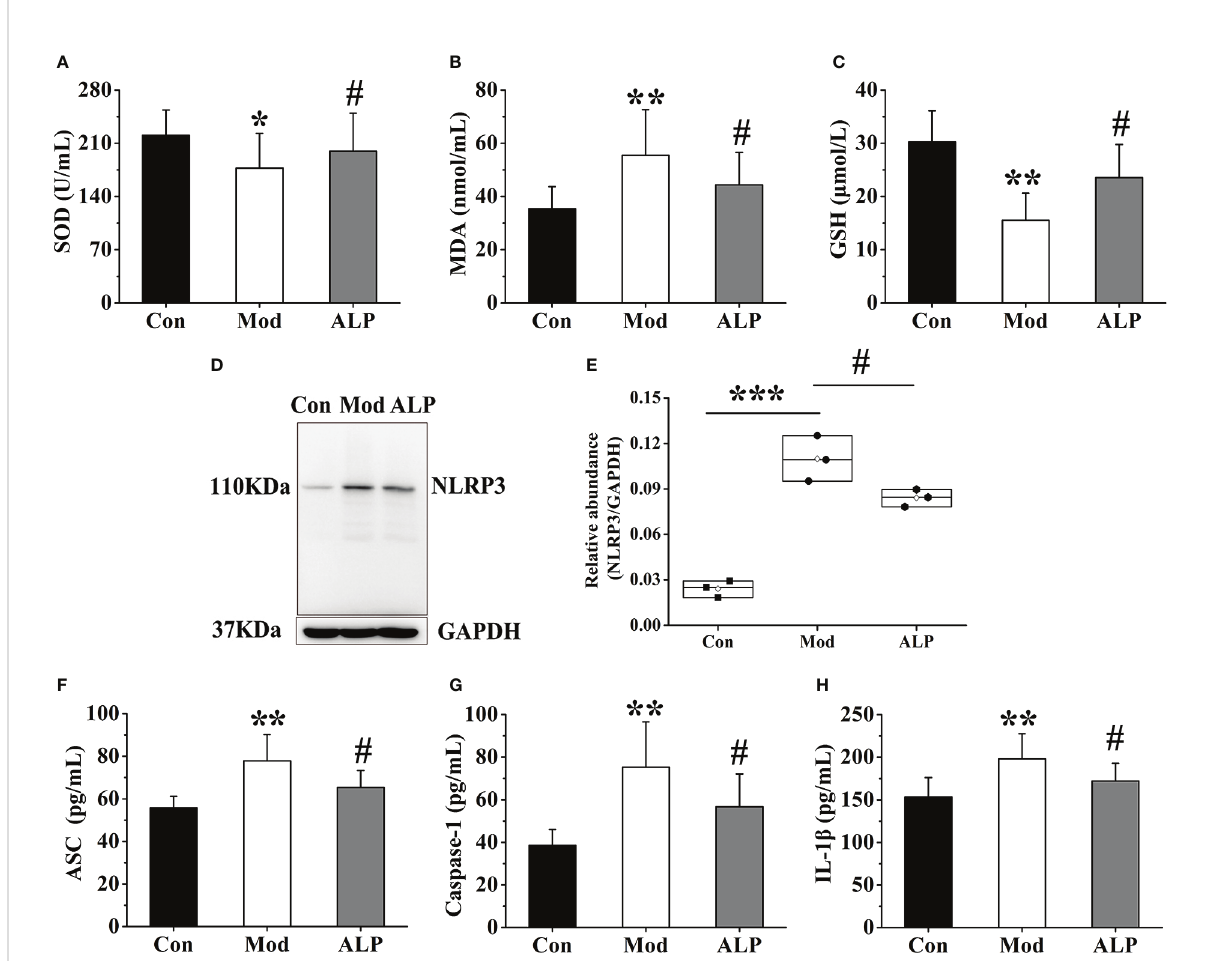
FIGURE 7 Allopurinol alleviates oxidative stress and NLRP3 in fl ammasome in gouty quail. (A) The content of SOD in the joint synovial tissue. (B) The content of MDA in the joint synovial tissue. (C) The content of GSH in the joint synovial tissue. (D) Western blot was conducted to evaluate the protein level of NLRP3 and GAPDH in synovial tissue. (E) Box plot showing the densitometry analysis of NLRP3 normalized by GAPDH. (F) The expression level of ASC in synovial tissue. (G) The expression level of Caspase-1 in synovial tissue. (H) The expression level of IL-1 b in synovial tissue. Data are expressed as mean ± SEM for 8 quails in each group. * P < 0.05, ** P < 0.01 and *** P < 0.001 versus Con group. # P < 0.05 versus Mod